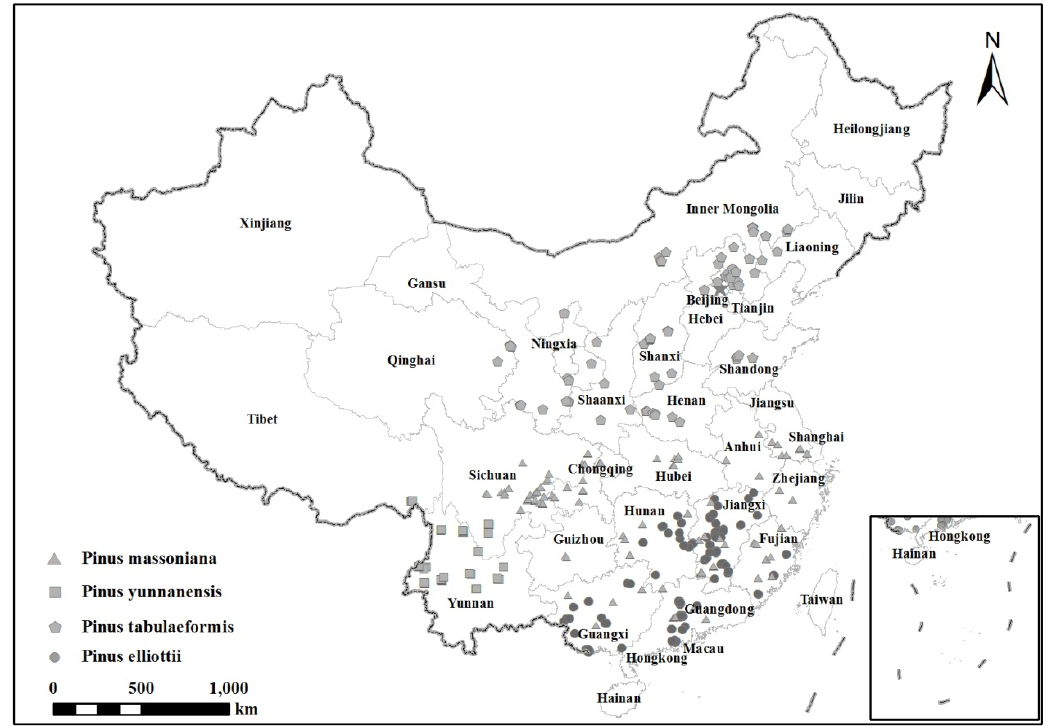
Figure 1. Location of sample trees in